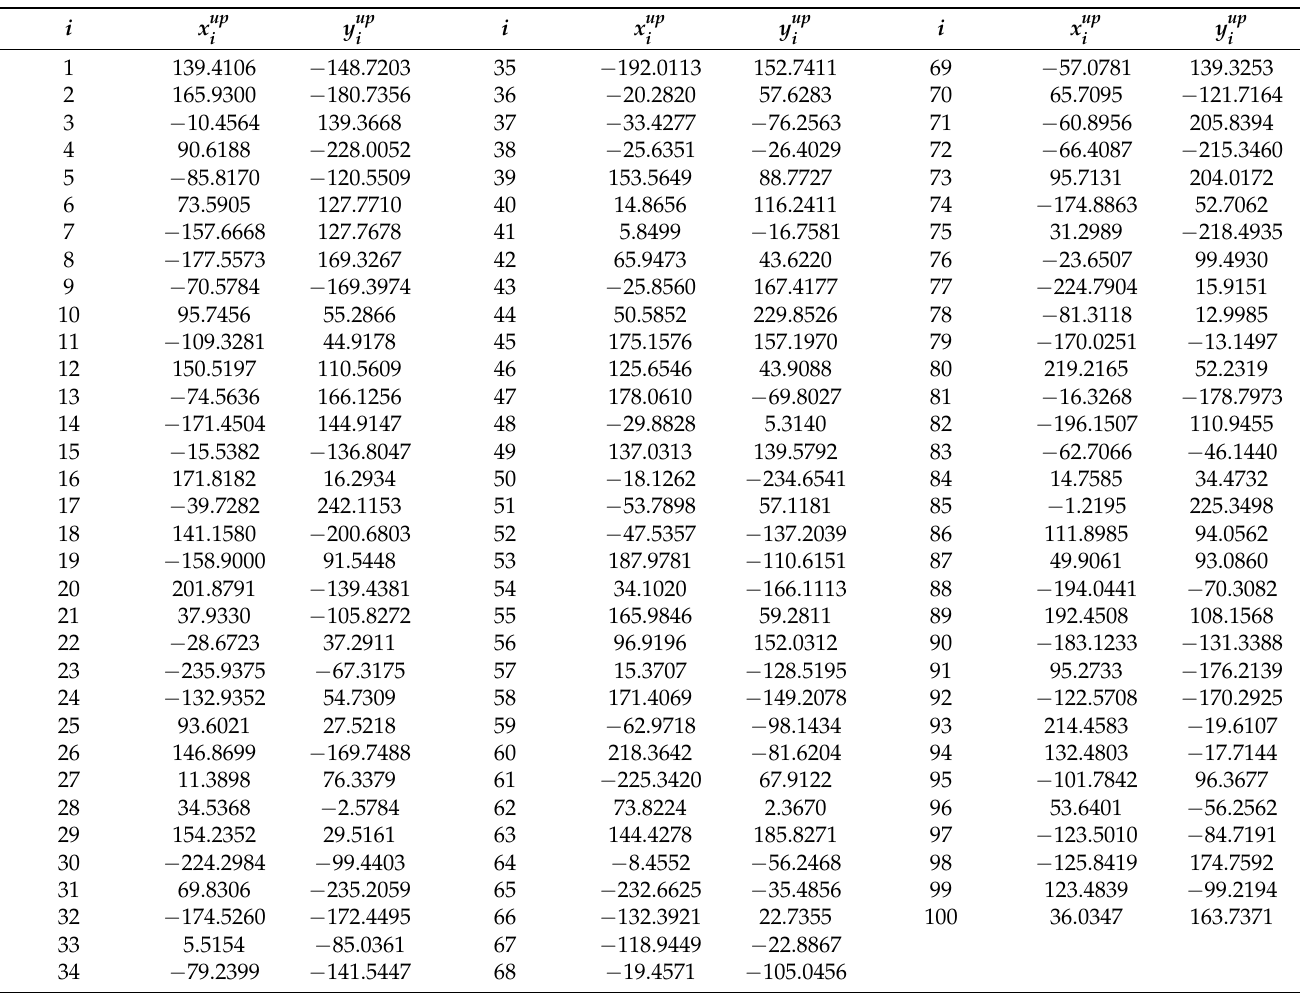
Figure 5. Placement of 100 circles for the parallel solution, r up = 257.1951 . Table 2. Coordinates of the placement of 100 circles for the sequential solution, r up = 257.35311